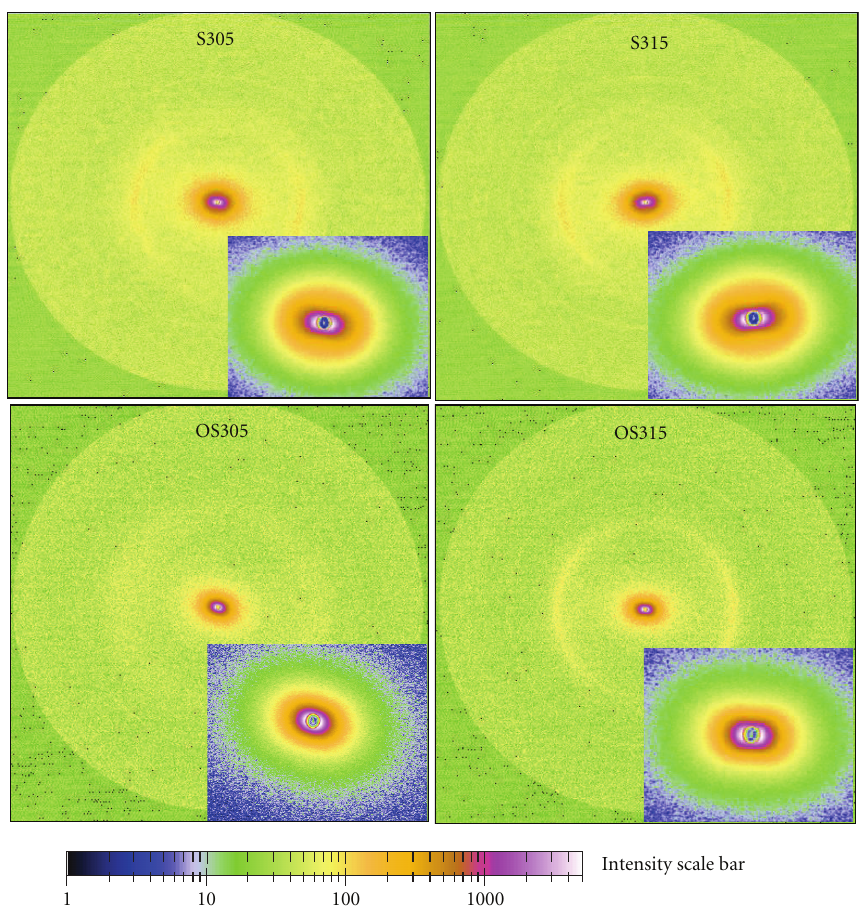
Figure 3: Raw di ff raction patterns for selected ternary composites; S305, S315, OS305, and